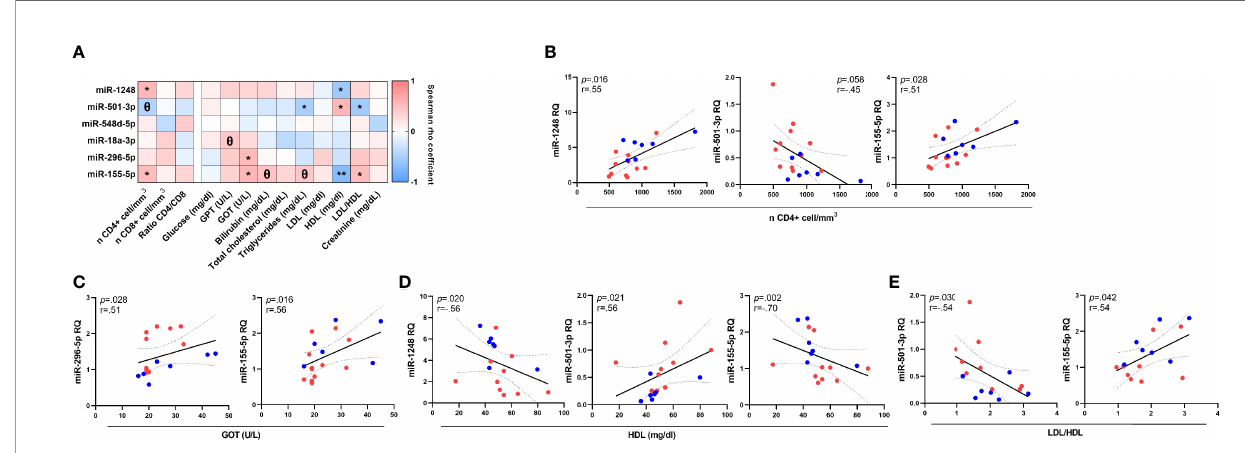
FIGURE 2 | Associations between miRNA relative levels and immunological and biochemical parameters on HIV-1-infected young adults. Correlations of miRNAs relative quantity (RQ) with all soluble immunological and biochemical parameters (A) . Signi fi cant and close to signi fi cant associations with T-CD4+ cell count (B) , Glutamic Oxaloacetic Transaminase (Aspartate Aminotransferase) (GOT; AST) (C) , high-density lipoprotein cholesterol (HDL) (data available for 16 patients) (D) and LDL/HDL ratio (LDL: low-density lipoprotein cholesterol) (data available for 16 patients) (E) . Patients from EARLY treated group (n=7) are highlighted with blue dots and red dots represent LATE treated HIV-1-young adults (n=11). The Spearman rho correlation coef fi cient test was used. ** p <0.01, * p <0.05, Q 0.05< p < 0.1.